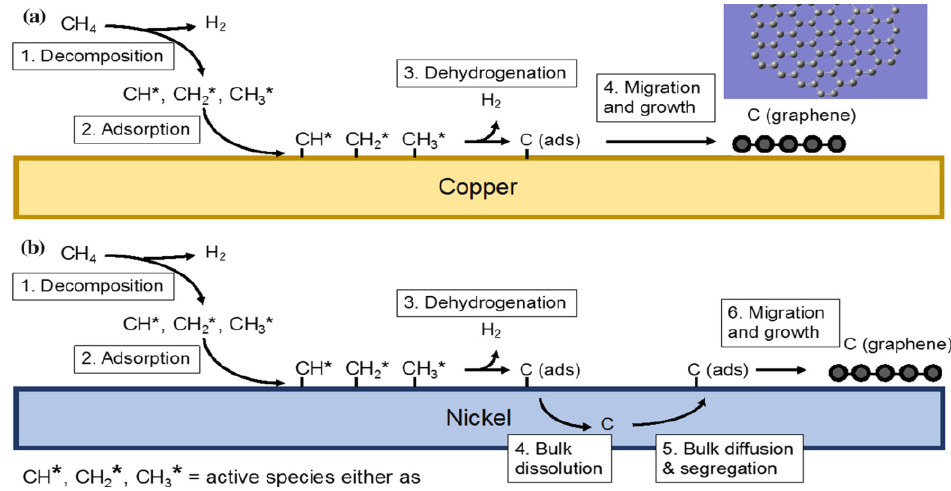
Figure 4. Schematic diagram showing deposition of graphene on ( a ) copper and ( b ) nickel substrates. Reproduced from [54] with permission of the American Chemical Society.